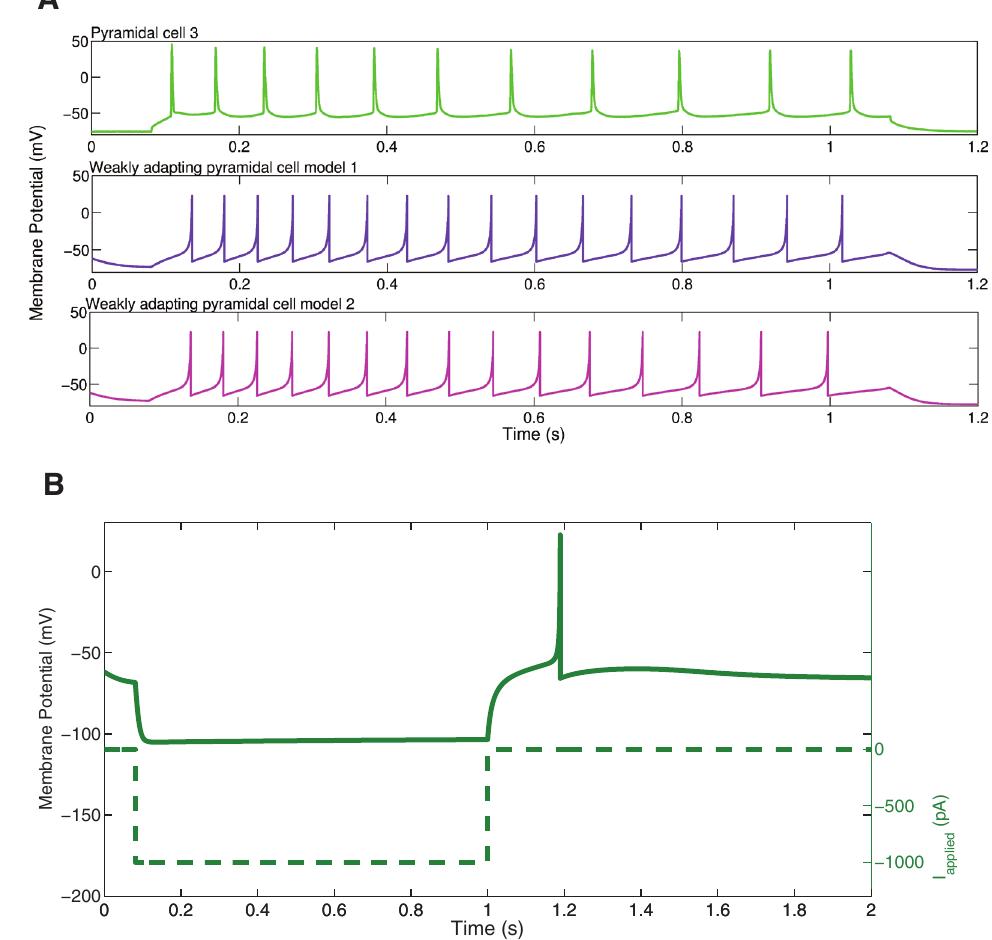
Figure 6. A : An example intracellular recording of Pyramidal cell 3 during current clamp with applied current of 154 pA (top, light green) is compared with the firing of our weakly adapting pyramidal cell models, also with an applied current of 154 pA (model 1: middle, purple; model 2: bottom, magenta). The firing rates and amount of adaptation of the model are similar to those of the experiment. B : An example of rebound firing in our weakly adapting model 1. A one-second step of 1000 pA hyperpolarizing input is applied (dashed line). The weakly adapting model produces rebound spiking (solid line), but requires a reasonably large amount of applied input. The weakly adapting model 2 does not produce rebound spiking following steps of hyperpolarizing input in the physiological